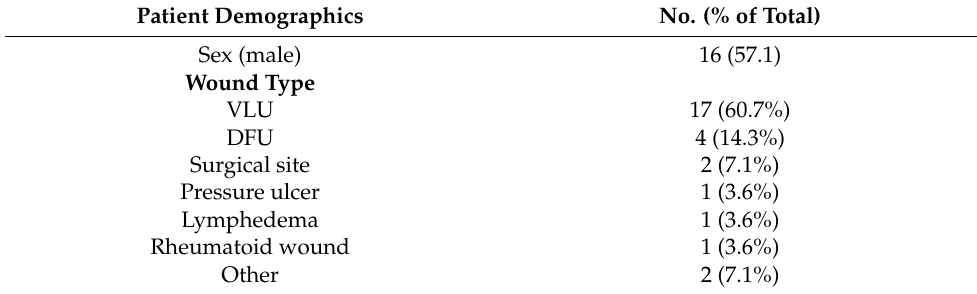
Table 2. Patient